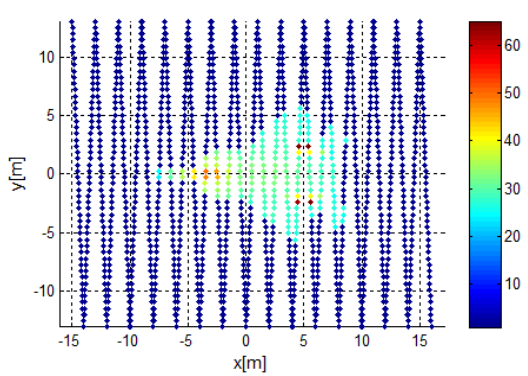
Figure 19. Intersecting point cloud computed by geometric simulation